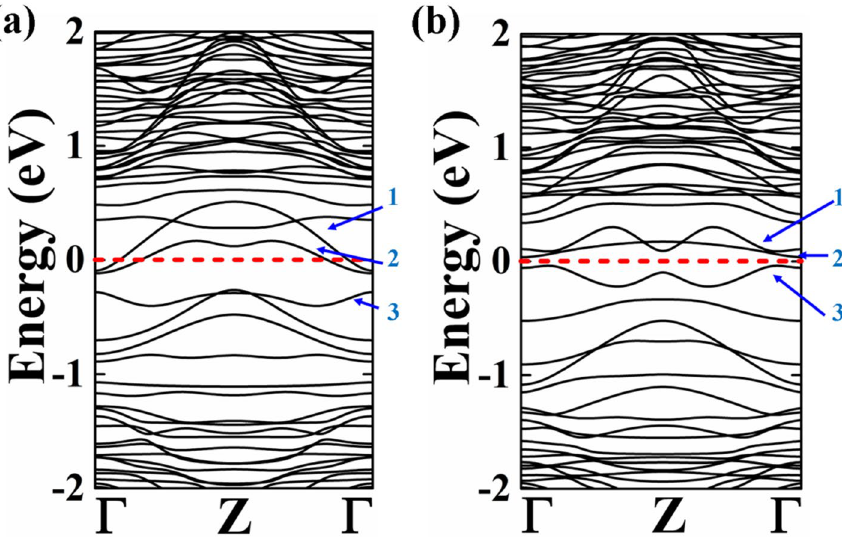
Figure 3. Electronic band structure of ( a ) NW with the Sb vacancy and ( b ) NW with the Ge vacancy.